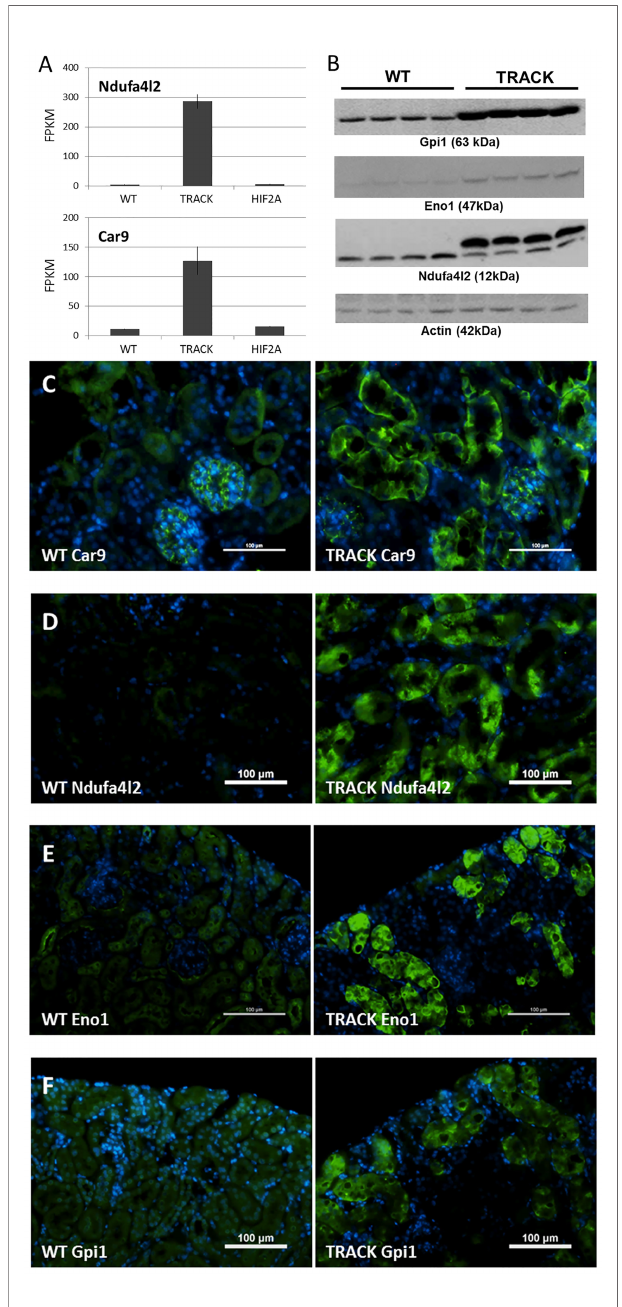
FIGURE 1 | Ndufa4l2and Car9levels inthe TRACK (HIF1 a ) ccRCC mouse model. (A) Transcriptlevelsof Ndufa4l2 and Car9in TRACK datasets are elevatedin “ TRACK ” (HIF1 a ) relative to “ Normal ” (WT) samples, as previously reported (15, 28). Note that Ndufa4l2 and Car9levels are normal inthe HIF2 a mouse model. (B) Western blotting of Ndufa4l2, Actin,Eno1, and Gpi1. The intensities of correctly sized bands were increasedin the TRACK mice, thus validating the speci fi cities of the antibodies. All proteins were detected on the same membrane. (C – F) Immuno fl uorescence of Car9, Ndufa4l2, Eno1, and Gpi1 inWTand TRACKkidneys(shown ingreen), DAPI nuclear staining in blue. (C) Car9, (D) Ndufa4l2, (E) Eno1, (F) Gpi1. Magni fi cation;x200, scalebar;100 m m. Representativeimages are shown. Note that under denaturingconditions (B) , the Ndufa4l2 antibody recognizes also Ndufa4, however,the absence ofsignal in WT kidneys (C) con fi rms the speci fi city inthe immuno fl uorescence